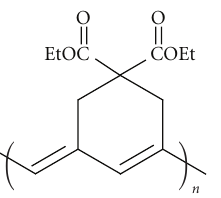
Figure 1: Chemical structure of